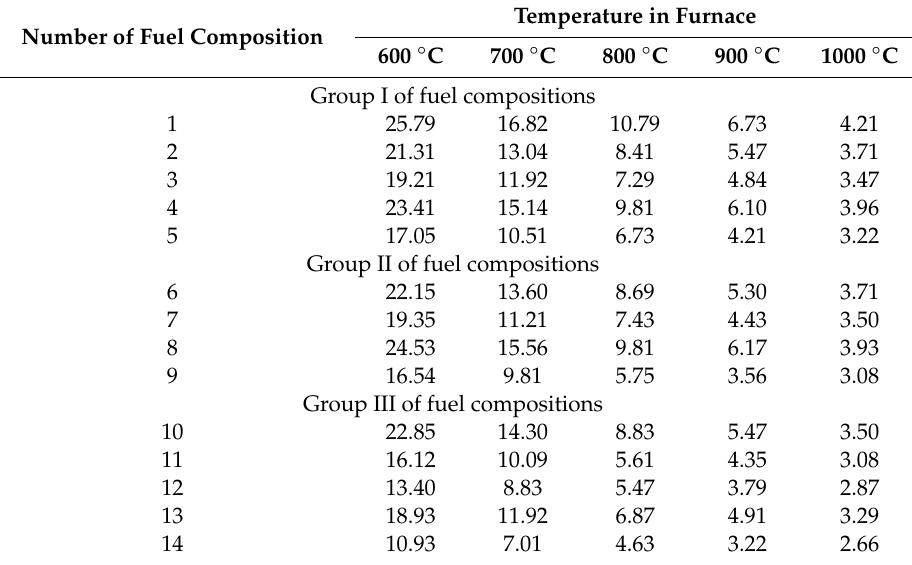
Table 5. Ignition delay times (s) of composite fuels.